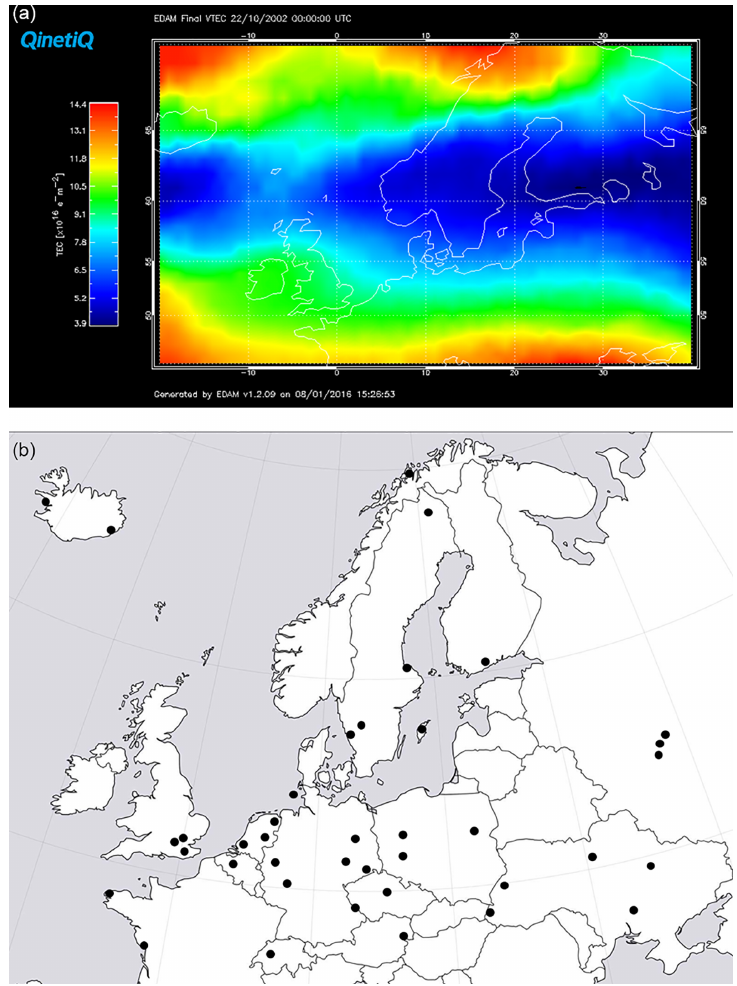
Figure 1. (a) Vertical TEC through the EDAM grid at 00:00UT on 22 October 2002. The spatial coverage of the figure extends from − 20.0 to 40.0 ◦ E and from 45.0 to 70.0 ◦ N. The trough extends across the field-of-view with its minimum TEC of approximately 4.0 TECU near 60.0 ◦ N. (b) A map showing the locations of the receivers used in the